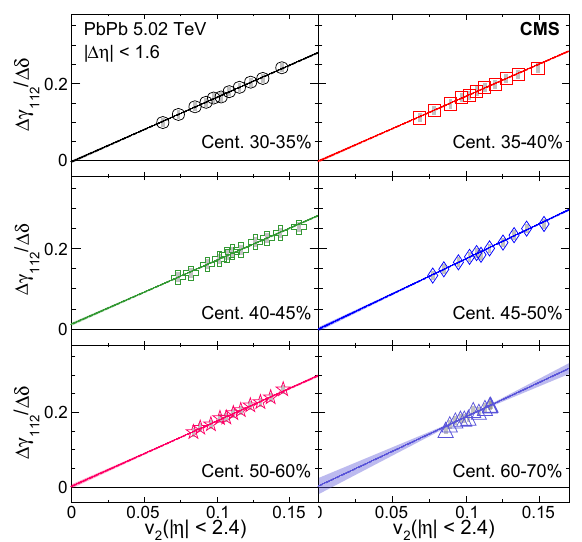
< 1 . 6, in pPb collisions for ∆ η Figure 4. The ratio of ∆ γ 112 and ∆ γ 123 to the product of v n and δ , averaged over Figure 5. The ratio between the di ff erence of the OS and SS three-particle correlators and the di ff erence of OS | | = 8 . 16 TeV (upper) and PbPb collisions at 5.02 TeV (lower) [14]. Statistical and the Pb-going direction at √ s and SS in δ correlators, ∆ γ 112 / ∆ δ , averaged over NN systematic uncertainties are indicated by the error bars and shaded regions, respectively. di ff erent centrality classes in PbPb collisions at √ s indicated by the error bars and shaded regions, respectively. A one standard deviation uncertainty from the fit is also shown.